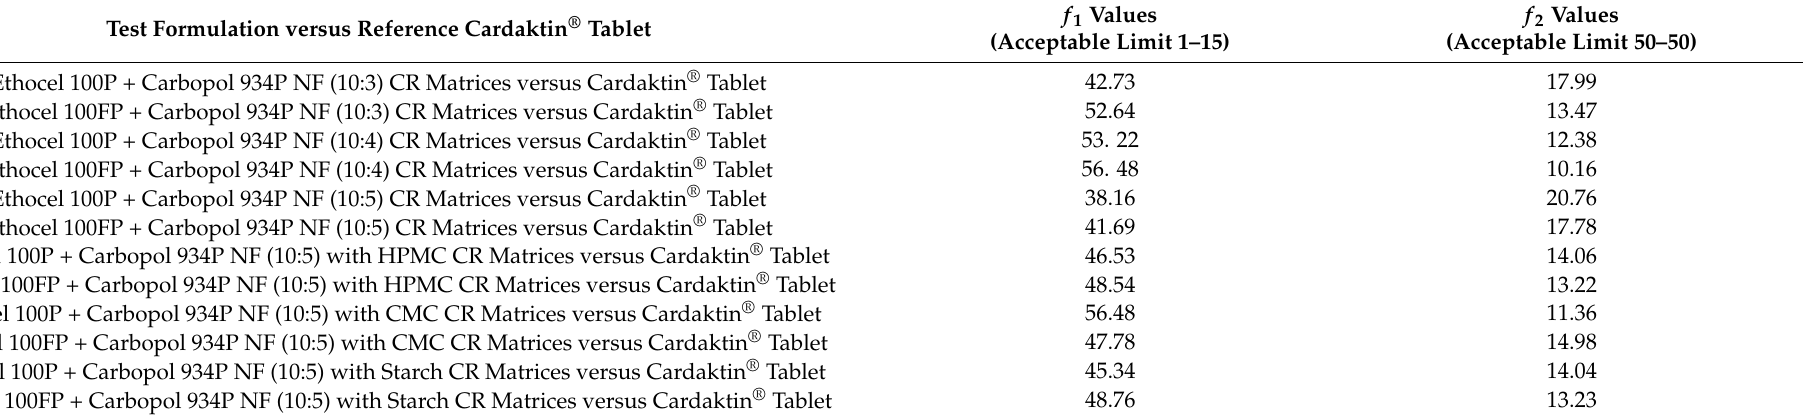
Table 6. Results of f 1 and f 2